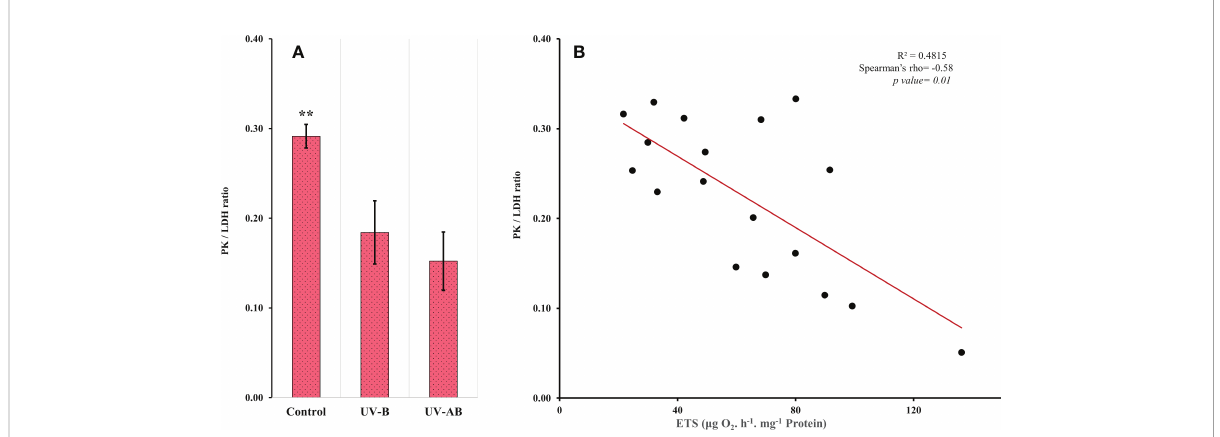
FIGURE 4 (A) Pyruvate kinase (PK)/lactate dehydrogenase (LDH) activity ratio. N = 8 (control), 5 (UV-B), and 6 (UV-AB). Data represent the mean ±SE; an asterisk above bars means statistical signi fi cance ( ∗ p ≤ 0.05 , ∗∗ p ≤ 0.01 ). Statistical signi fi cance was tested using Tukey HSD test for multiple comparisons. (B) Scatter plot showing the correlation between the ETS and PK/LDH ratio. Spearman ’ s